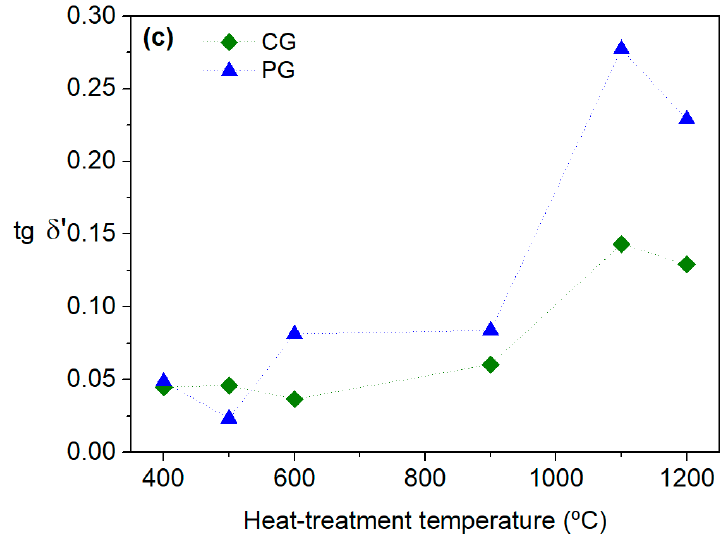
Figure 15. ( a ) Dielectric constants, ( b ) dielectric losses and ( c ) loss tangents at room temperature for the samples prepared via the colloidal gel and polymeric gel methods.